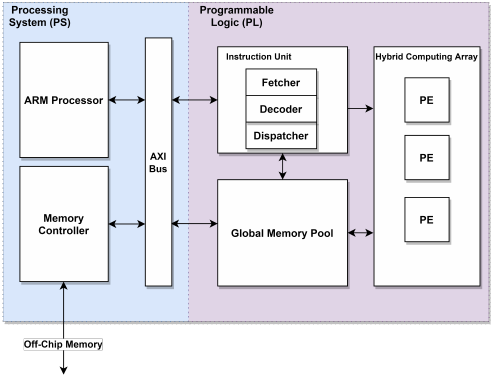
Figure 7. Xilinx Deep Learning Processing Unit (DPU) top-level architecture